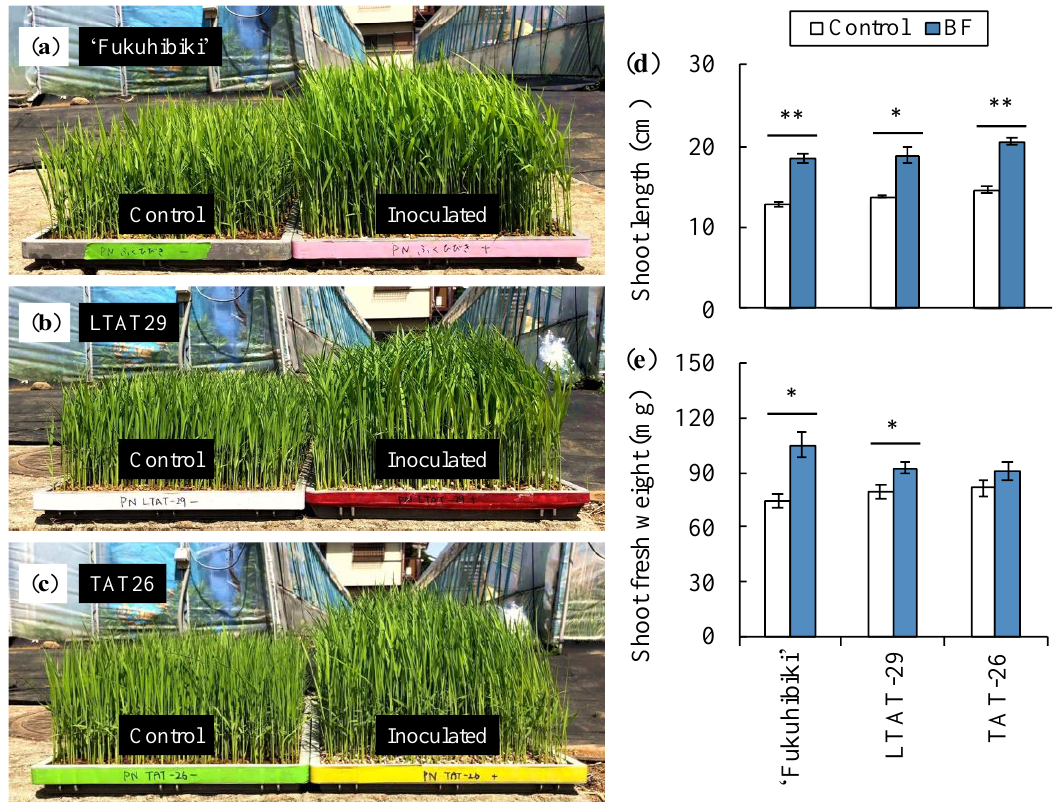
Figure 2. The shoot inoculated with Kikuichi/Yume-bio in the nursery box at the transplanting stage. The seedlings of ( a ) ‘Fukuhibiki’ at 21 days after sowing, and ( b ) LTAT-29 and ( c ) TAT-26 at 14 days after sowing on the nursery box are shown. The measured ( d ) shoot length and ( e ) shoot fresh weight are also indicated. * and ** indicate significant differences at p ≤ 0.05 and 0.01 levels between control and biofertilizer application in each treatment, respectively ( t -test, two-sided). Error bar indicates standard deviation (SD). n = 3.